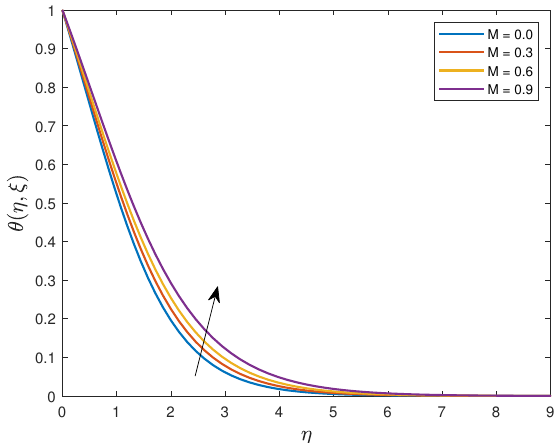
Figure 29. The influence of M on fluid temperature.